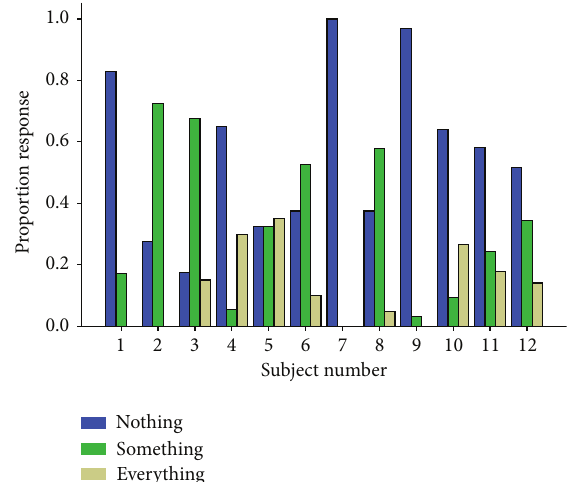
Figure 2: Proportion response in subjective rating task for every individual participant.